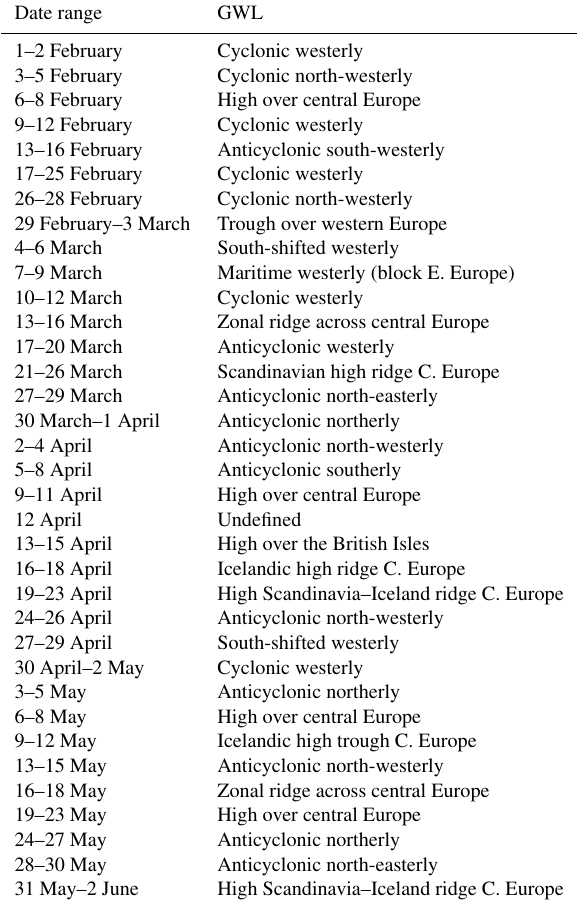
Table A2. GWL classification for the period 1 February–31 May 2020.